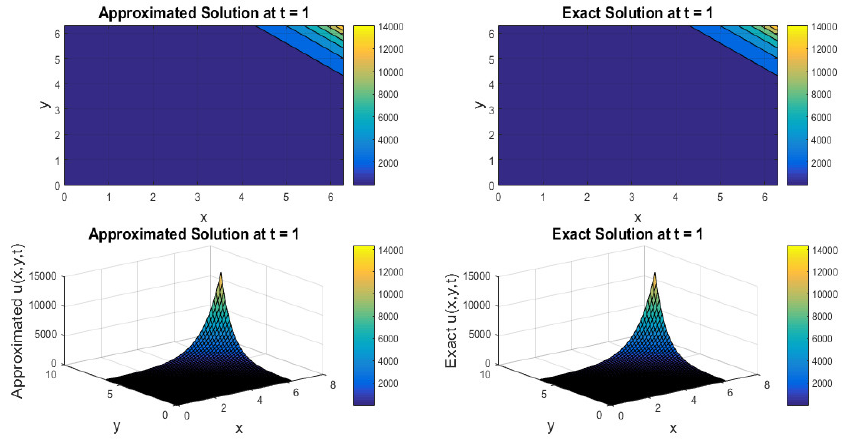
Figure 6. Comparison of approx. and exact profiles at t = 1 regarding Example 6.